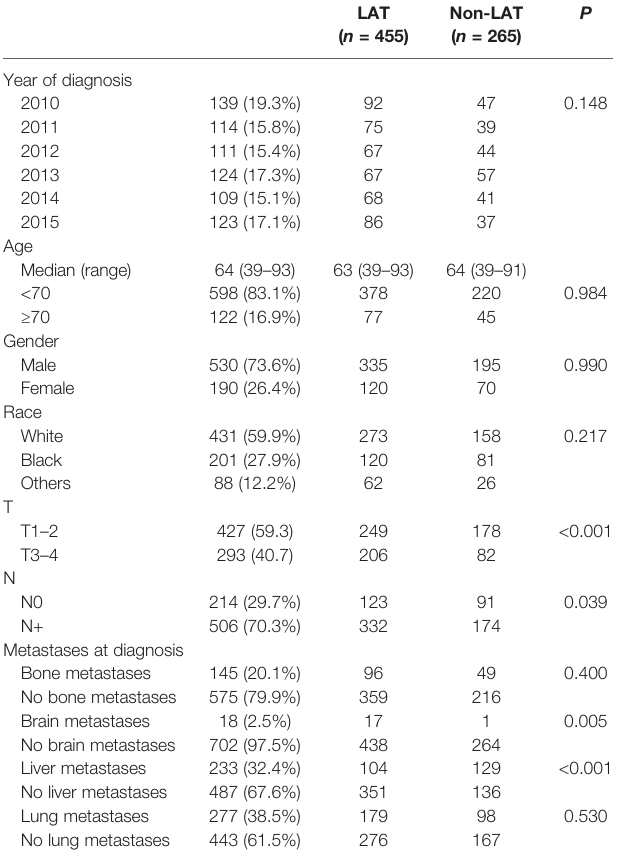
TABLE 1 | The correlation between clinical parameters and LAT